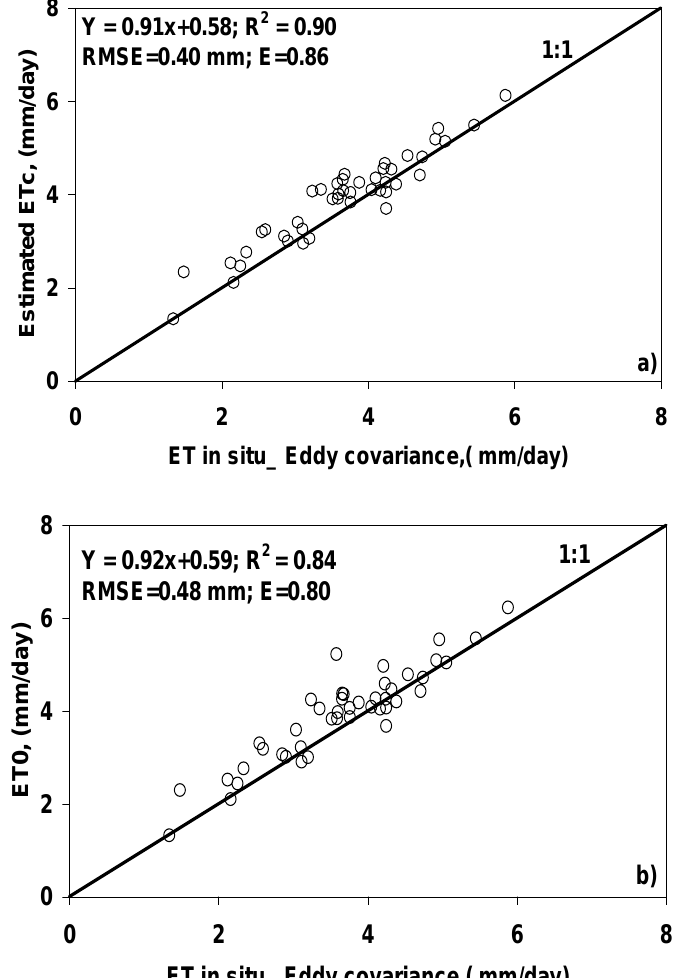
Figure 6. Same as Figure 5, but for one field (field 1) of mature wheat under standard conditions (no stress) and the soil evaporation was